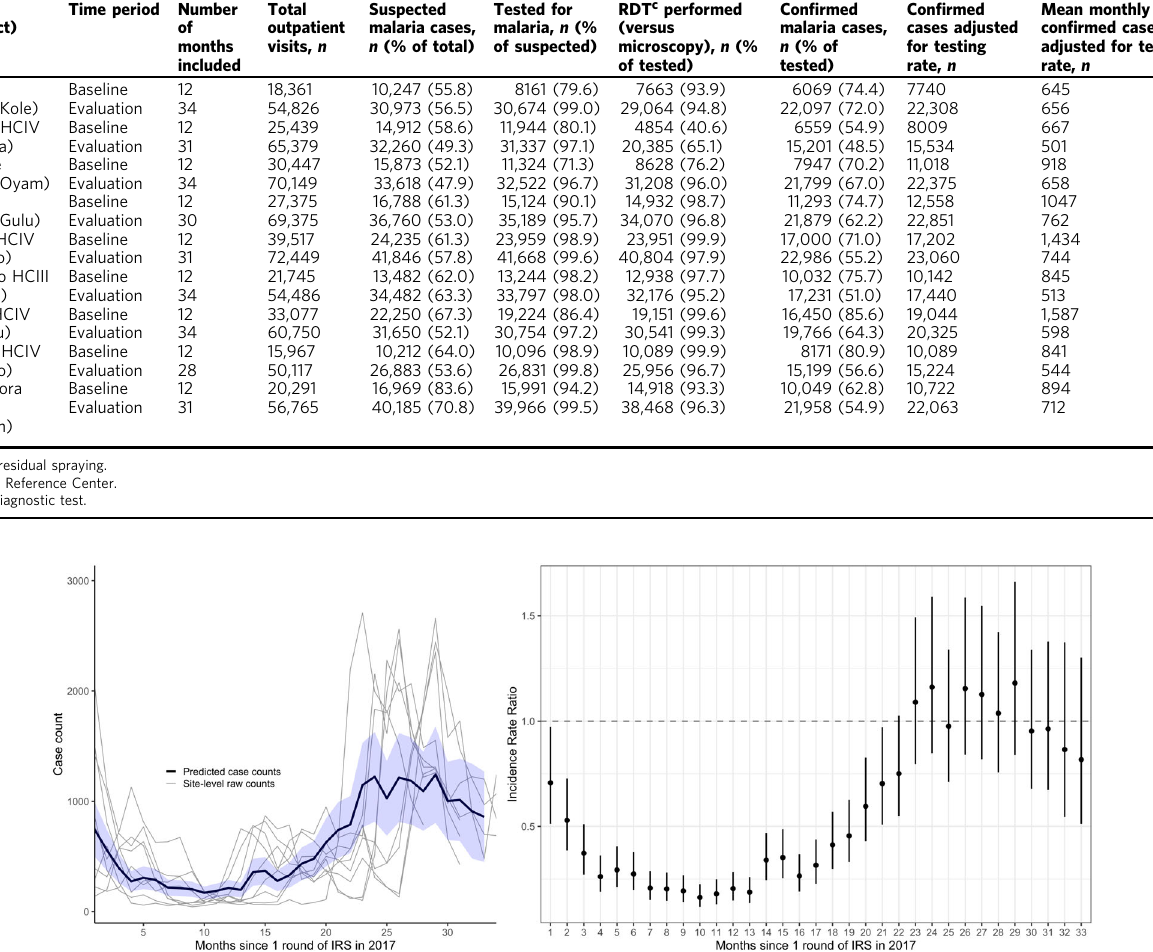
Fig. 4 Predicted case counts and adjusted incidence rate ratios (IRR) from multilevel negative binomial model assessing the impact of restarting indoor residual spraying (IRS) with a single round. The blue shaded region on the left represents the 95% con fi dence interval around the mean predicted case counts across sites from the adjusted regression model. Gray lines represent observed monthly case counts from individual sites. On the right, vertical bars represent the 95% con fi dence interval around the adjusted IRR (the measure of center for the error bars).